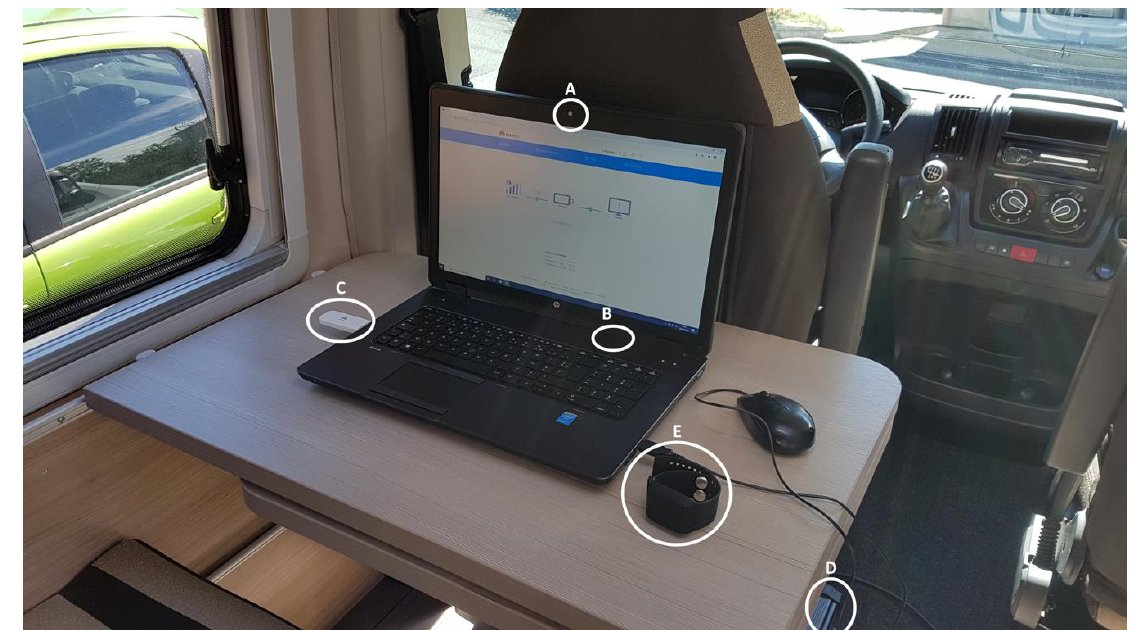
Figure 3. The laptop from the participants’ side ( A ) integrated microphone and webcam. ( B ) integrated speakers. ( C ) 4G key for internet connection. ( D ) Converter battery attached to the van’s electric plug to charge the laptop. ( E ) Empatica E4 wristband for stress measurement retrieval.